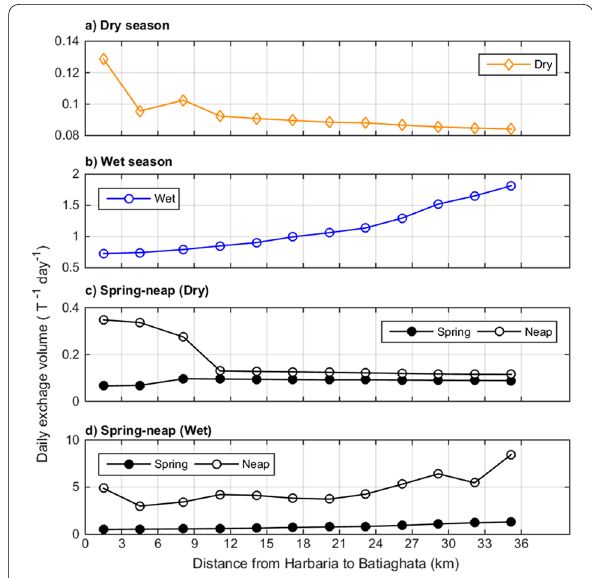
Fig. 11 Spatial variation of daily exchange volume for multiple estuarine segments of the Pasur River Estuary during spring and neap tides in the dry and wet seasons